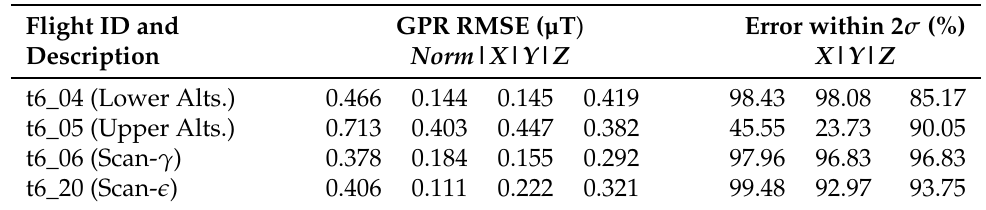
Table 3. GPR error for multi-altitude intermediate map trained on n 2 = 2001 observations from tests t6_00, t6_01, t6_03, and